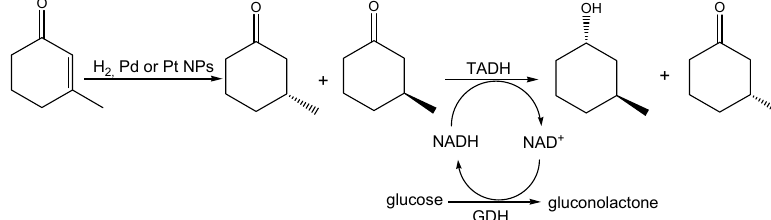
Table 1. Effect of H 2 pressure on conversion and selectivity of the Pd and Pt-catalyzed reduction of 3- methyl-2-cyclohexenone to 3-methylcyclohexanone. Reaction conditions: